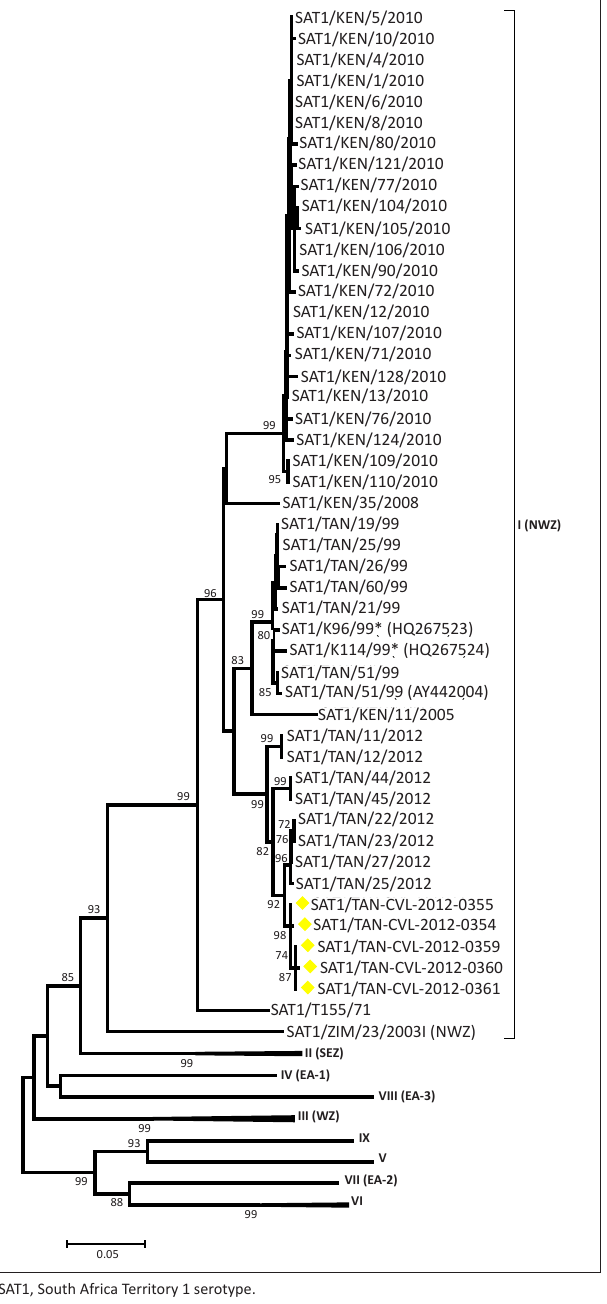
FIGURE 3: Midpoint-rooted neighbour-joining tree (based on the complete virus protein 1 coding sequence) showing the relationships between the foot-and- mouth disease virus serotype South Africa Territory 1 isolates from Tanzania (see yellow coloured diamonds) and other contemporary and reference